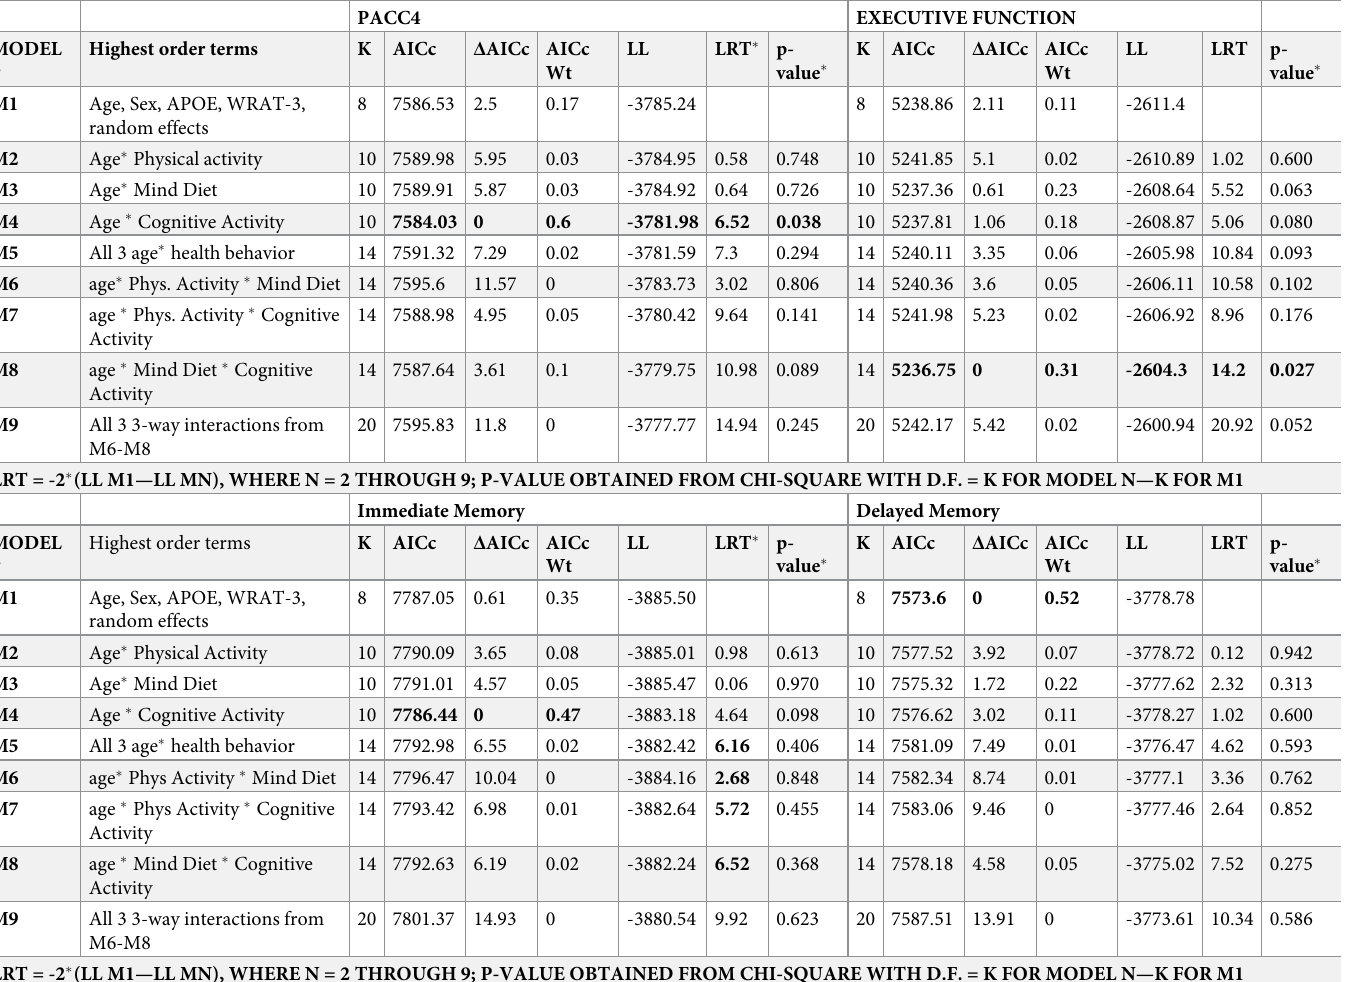
Table 3. Model fit statistics, AICc, model weights, log-likelihood, and likelihood ratio